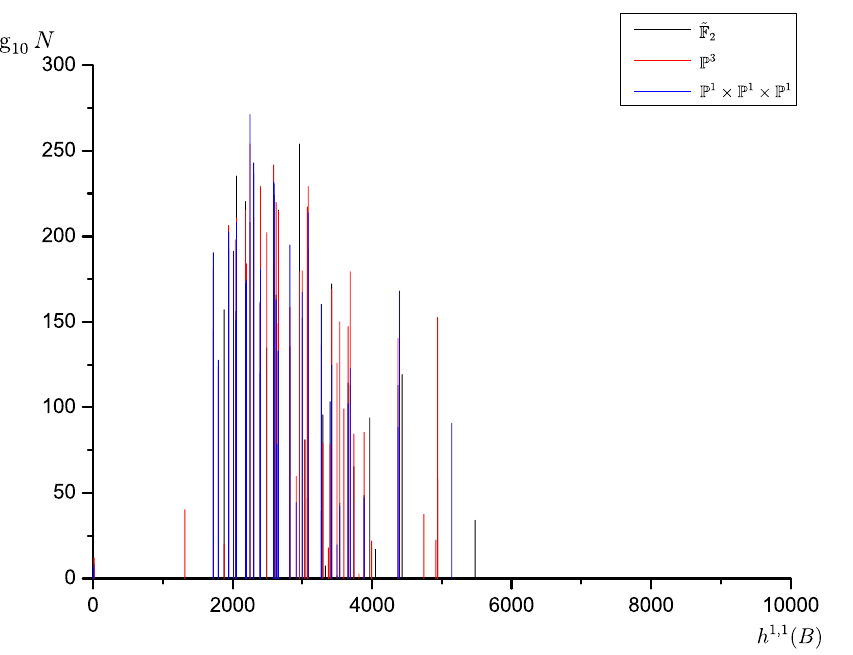
Figure 9 . Logarithm of the estimated number of good bases as function of h 1 ; 1 ( B ) from blowing up P 3 , ~ F 2 and P 1 (cid:2) P 1 (cid:2) P 1 .